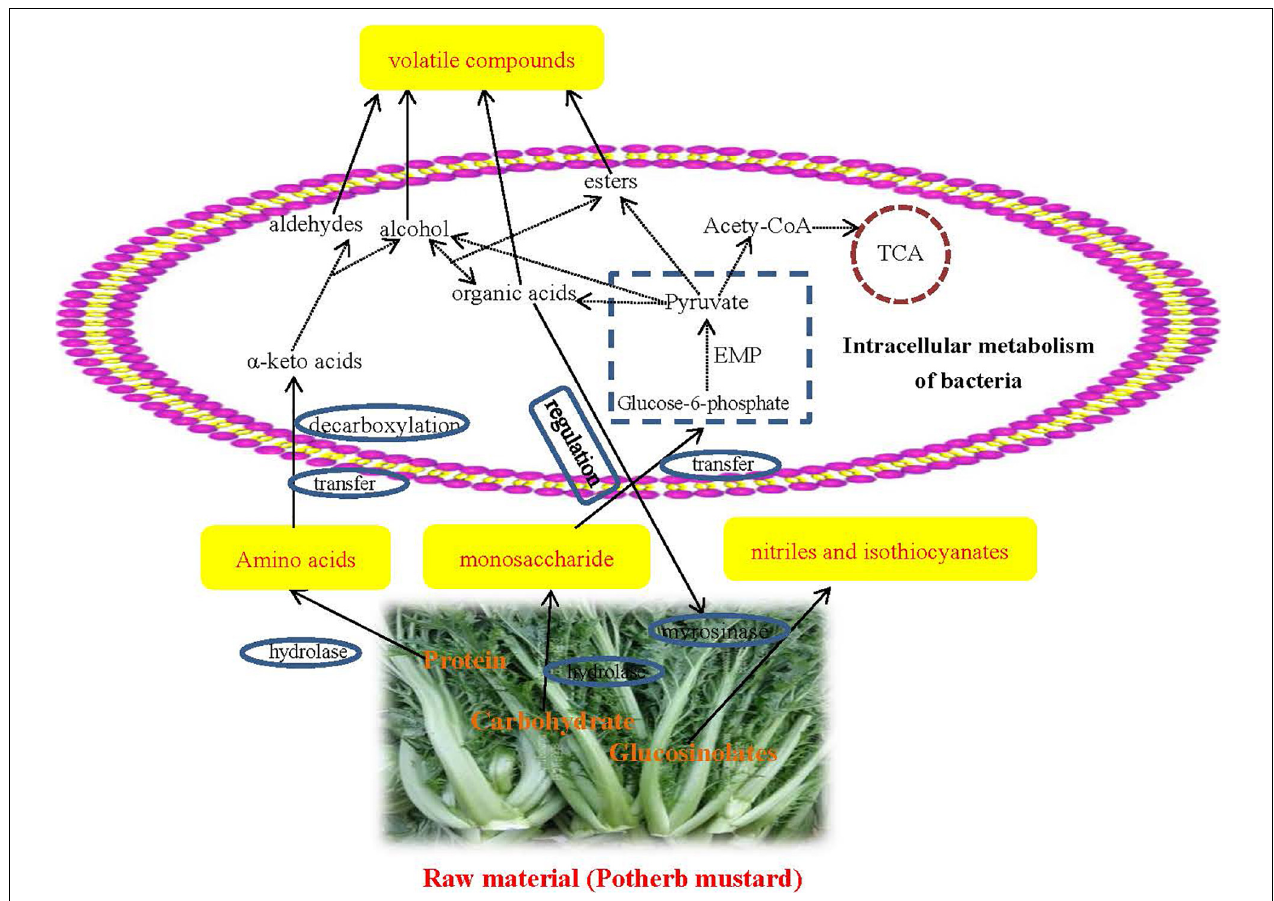
FIGURE 3 | Network diagram of preliminary formation mechanism of volatile flavors during the fermentation of